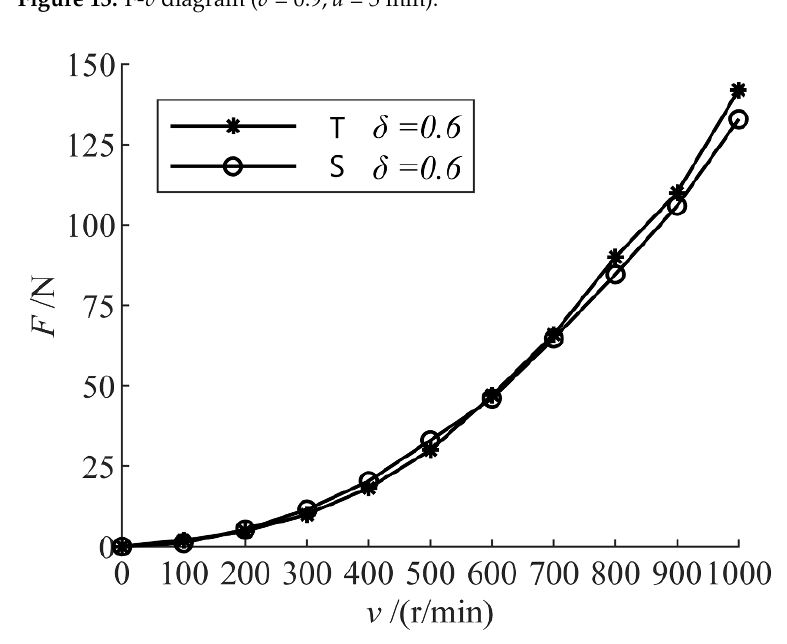
Figure 14. F- v diagram ( δ = 0.6 d = 5 mm).